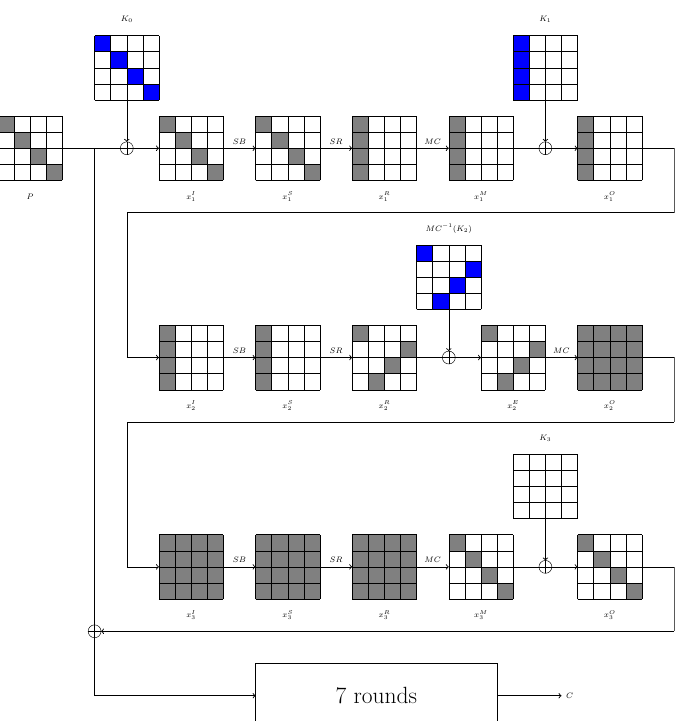
Figure 21: Key-recovery attack for Dual-AES-PRF 3 , 7